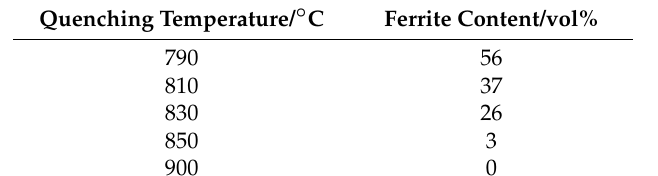
Figure 1. SEM microstructure of high-strength low-alloy (HSLA) steel quenched from ( a ) 790 °C, ( b )